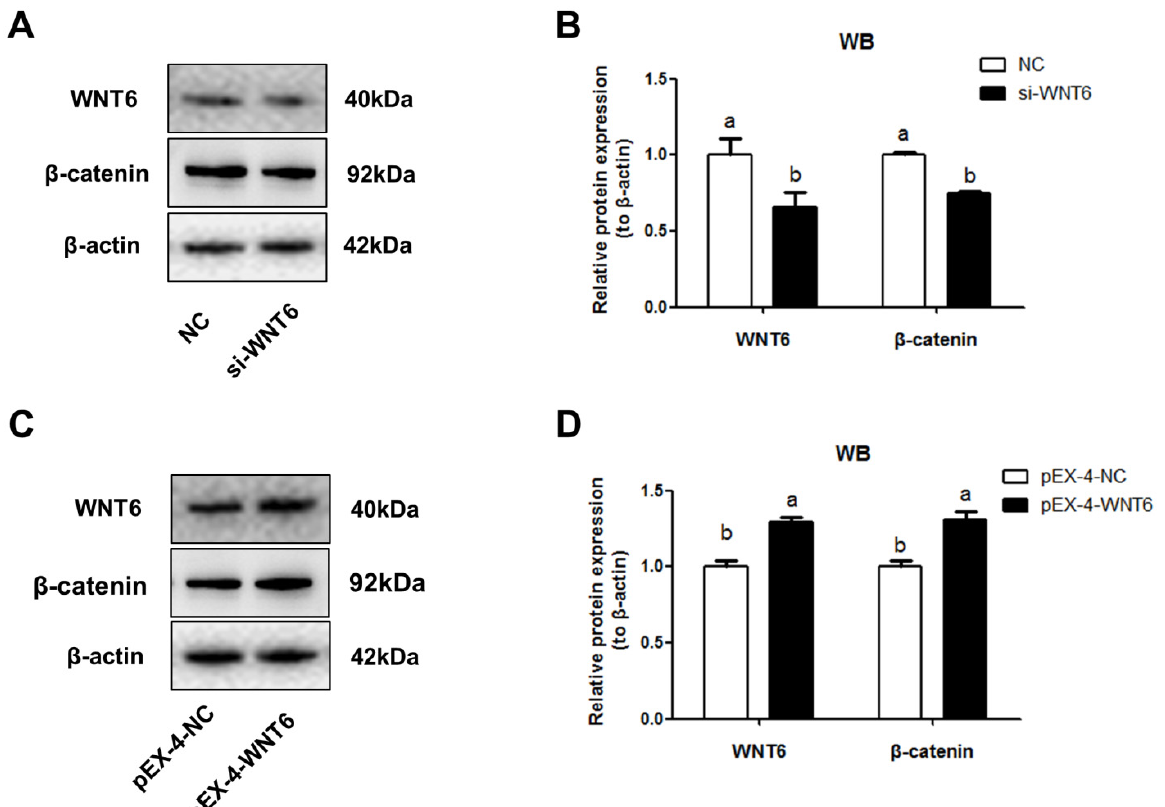
Figure 3. The effects of WNT6 transfection on β -catenin expression in EECs. ( A , B ) Relative expression of WNT6 and β -catenin protein to β -actin by WNT6 knockdown. ( C , D ) Relative expression of WNT6 and β -catenin protein to β -actin by WNT6 overexpression. si-WNT6, the small interfering RNA for WNT6 . pEX-4-WNT6, pEX-4 vector with WNT6 -CDs inserted. siRNA with scrambled sequence absent in the sheep genome and pEX-4 was severed as negative control for knockdown and overexpression, respectively. The values are presented as means ± SDs. Means with different letters indicate significant differences ( p < 0.05).